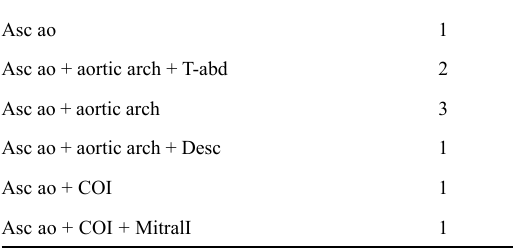
Table 2. Right Carotid Perfusion - Diagnosis (Aneurysm